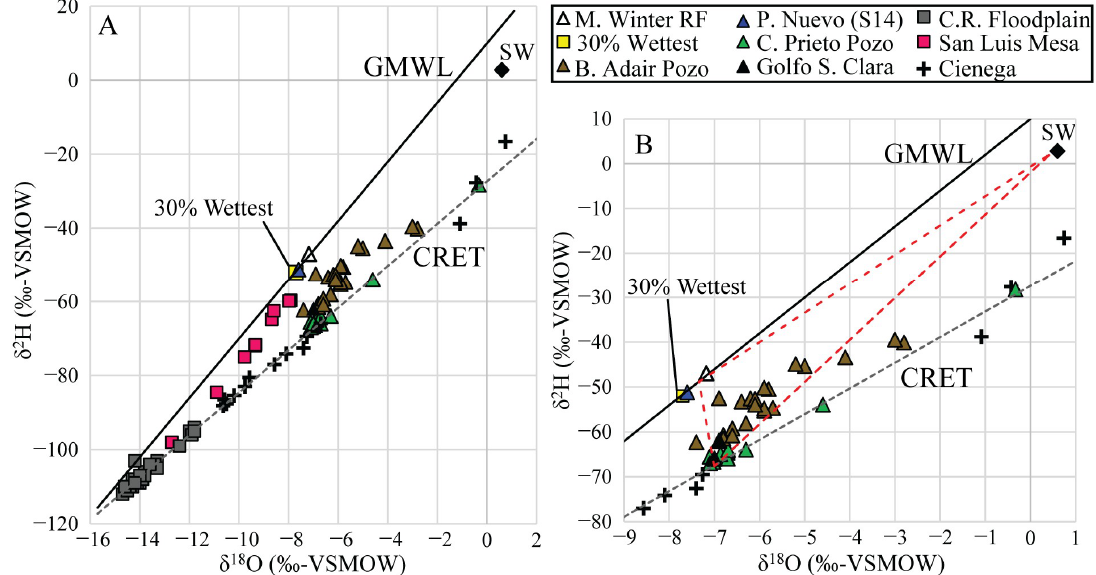
Figure 7. ( A ) δ 2 H vs. δ 18 O values for surface and groundwater from Colorado River floodplain, San